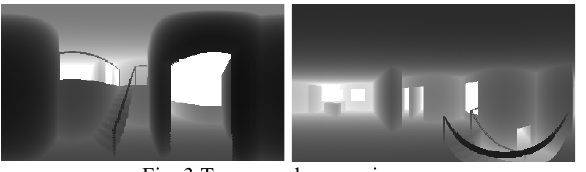
Fig. 3 Two sample range images